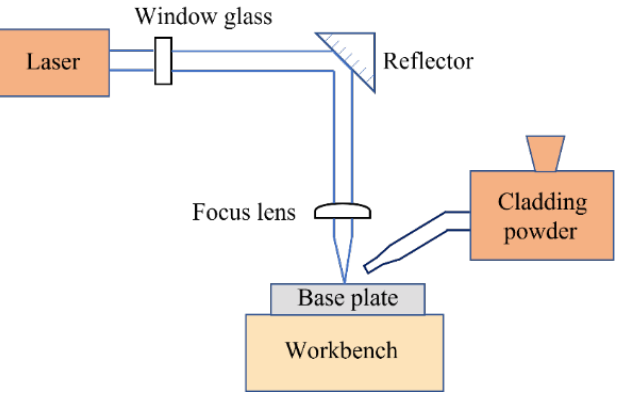
50 ppm. Figure 1 is a schematic diagram of the laser cladding treatment.